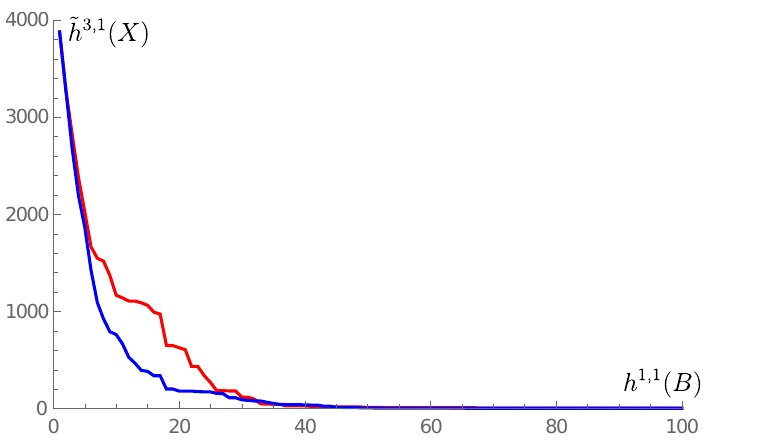
Figure 3 . An example of a common branch in a random graph. Only from the information of N out and N in along this branch, we get a substantially underestimated total number of nodes in the top layer: 5 . 27